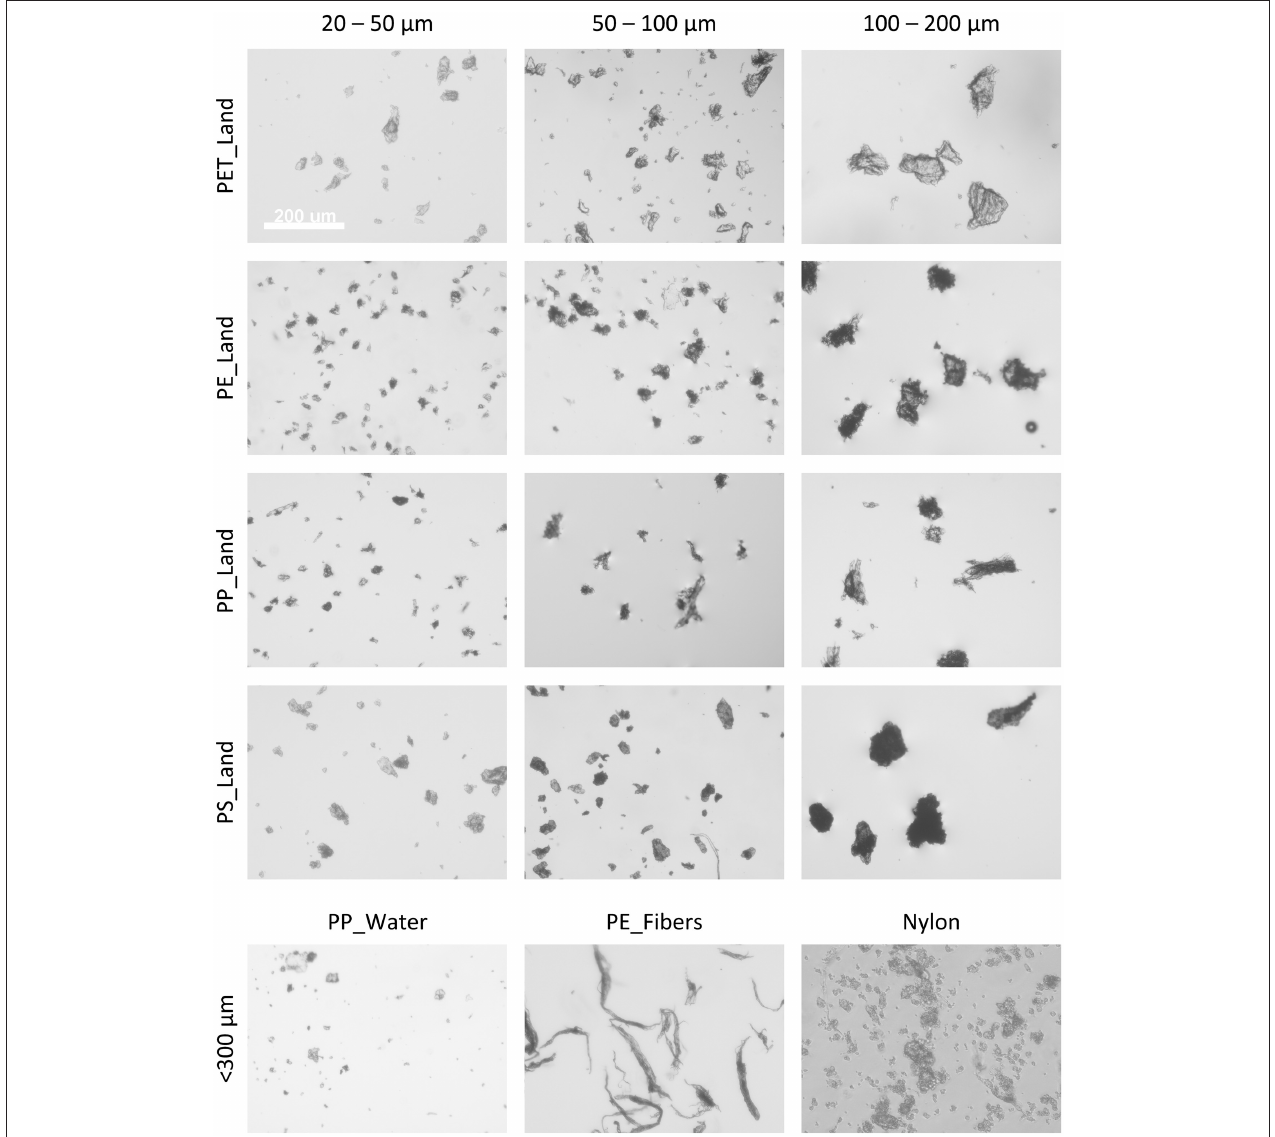
FIGURE 2 | Representative phase-contrast images of the various microplastic samples and size fractions. Images in grayscale, the white scalebar in the top-left image represents 200 µ m and is applicable to all images in this